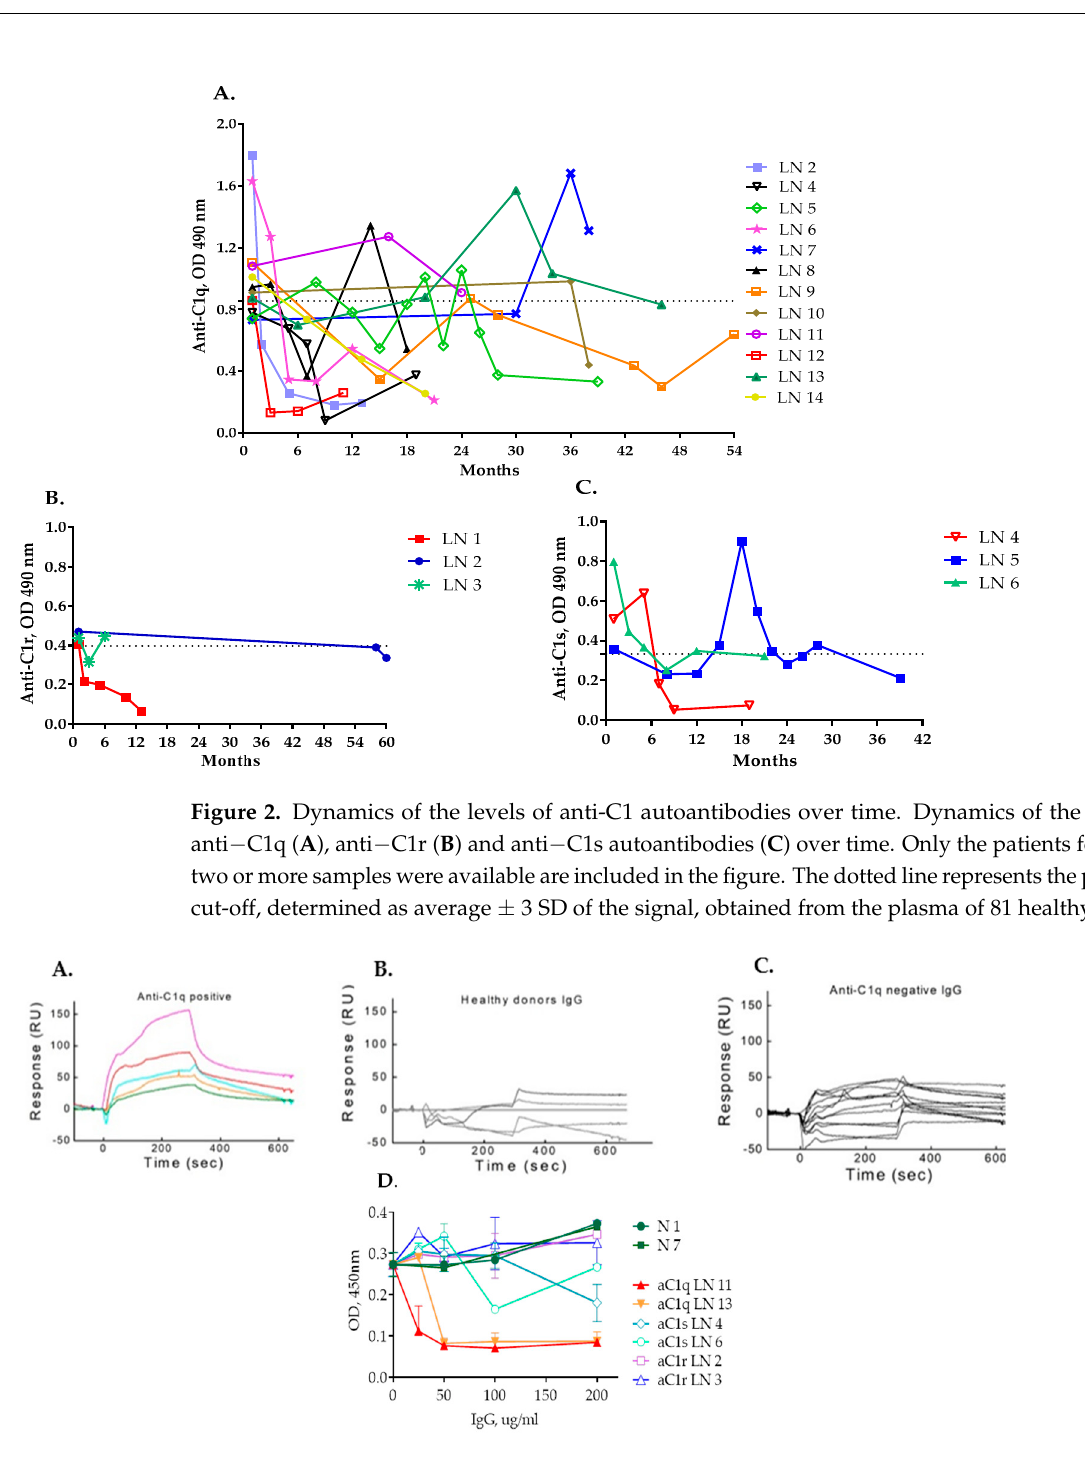
Figure 3. Assessment of the target antigen recognition by purified IgG. SPR sensorgrams for IgG binding to C1q of patients positive for anti − C1q antibodies by ELISA ( A ), of healthy volunteers ( B ) and of patients negative for anti-C1q antibodies by ELISA ( C ). Functional test for C1 complex formation ( D ).